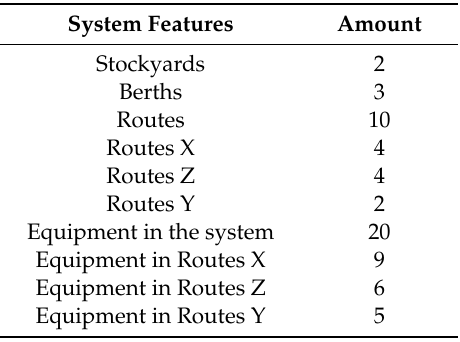
Table 5. Size of the sets used to generate the